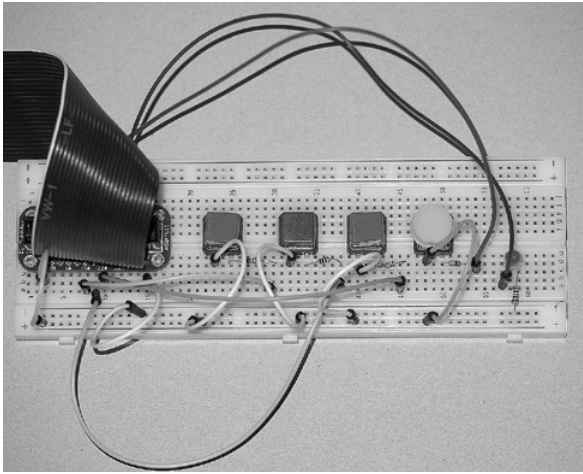
Figure 10: Prototyping the electronis of push